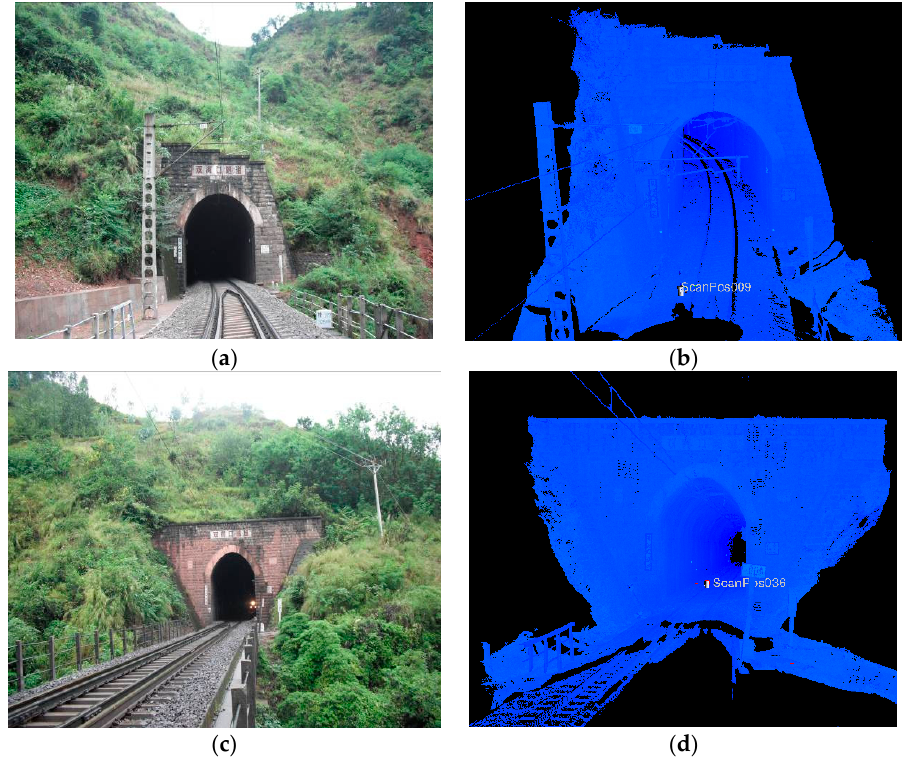
Figure 15. Picture and point cloud of tunnel entrance and exit. ( a ) Picture of tunnel entrance; ( b ) Point cloud of tunnel entrance; ( c ) Picture of tunnel exit; ( d ) Point cloud of tunnel exit.